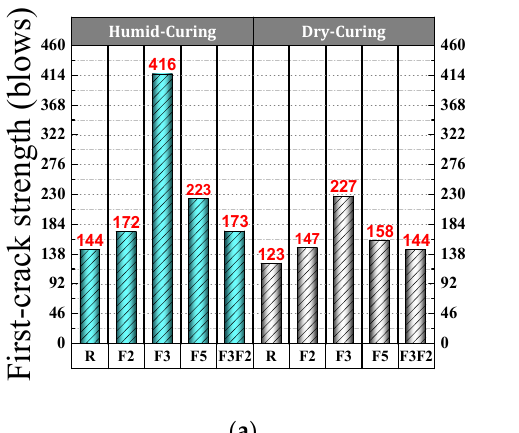
20 of 47 For the same curing conditions, the average number of blows for the first crack of fiber- reinforced concrete specimens of mixtures F2, F3, F5, and F2F3 were 172, 416, 223, and